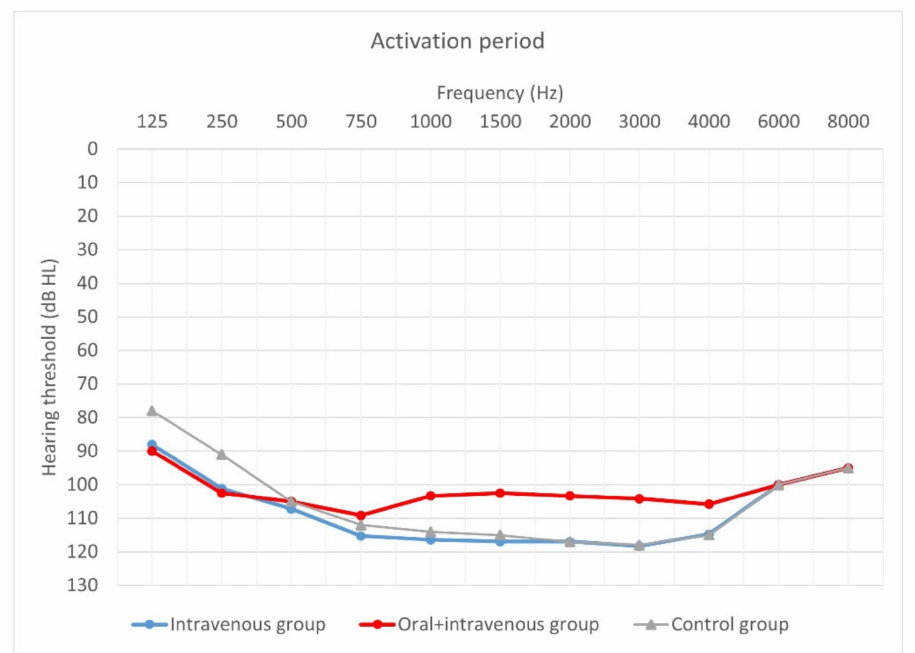
Figure 5. Mean hearing thresholds of patients with standard steroid therapy (i.v. group), patients with prolonged steroid therapy (oral + i.v. group) and control patients upon